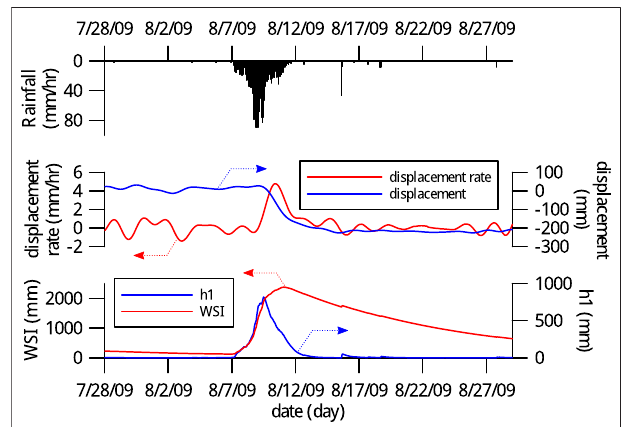
FIGURE 11 | Close-up time series plots of the 2009 Morakot typhoon triggered TienChih landslide. From the top panel: RI; middle: displacement, DR; bottom: h 1 and WSI. The DR is the negated time derivative of the GPS displacement.